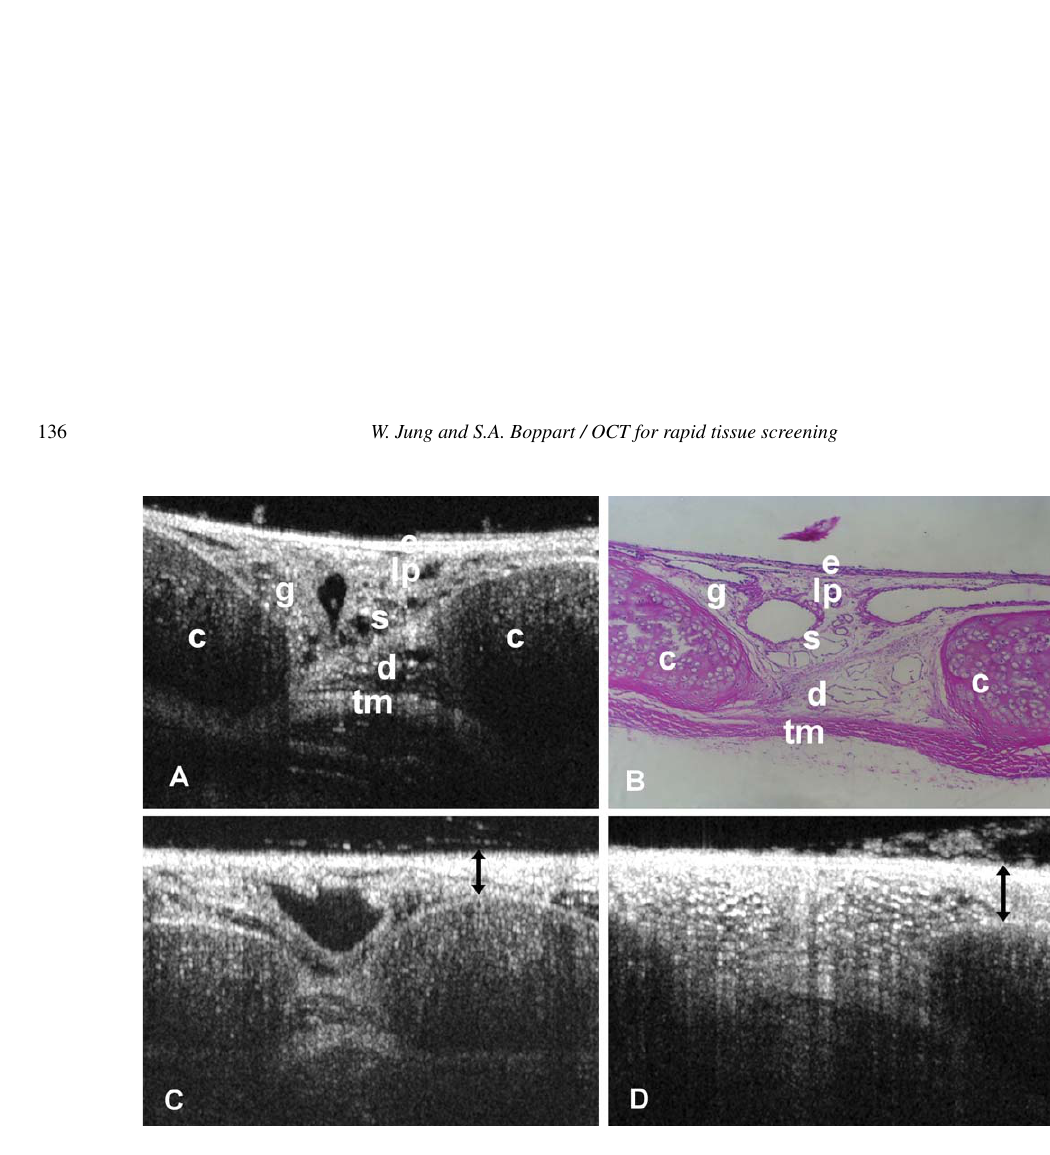
Fig.6. Respiratorytractimaging.Comparisonbetween(A)OCTand(B)correspondingH&Esection.ComparisonofOCTimagesobtainedfrom (C) normal and (D) septic rabbit trachea. In contrast to normal trachea, mucosal and submucosal edema is observed in the septic trachea. Arrows indicate difference in tissue thickness/swelling between normal and septic rabbit tracheas. The OCT images are 2 × 1.3mm with 10 × 10 (cid:1) m pixel size. Abbreviations: c, cartilage; e, epithelium; g, glands; lp, lamina propria; d, dense fibro elastic-tissue; s, submucosa; tm, tunica muscularis. Figure used with permission from